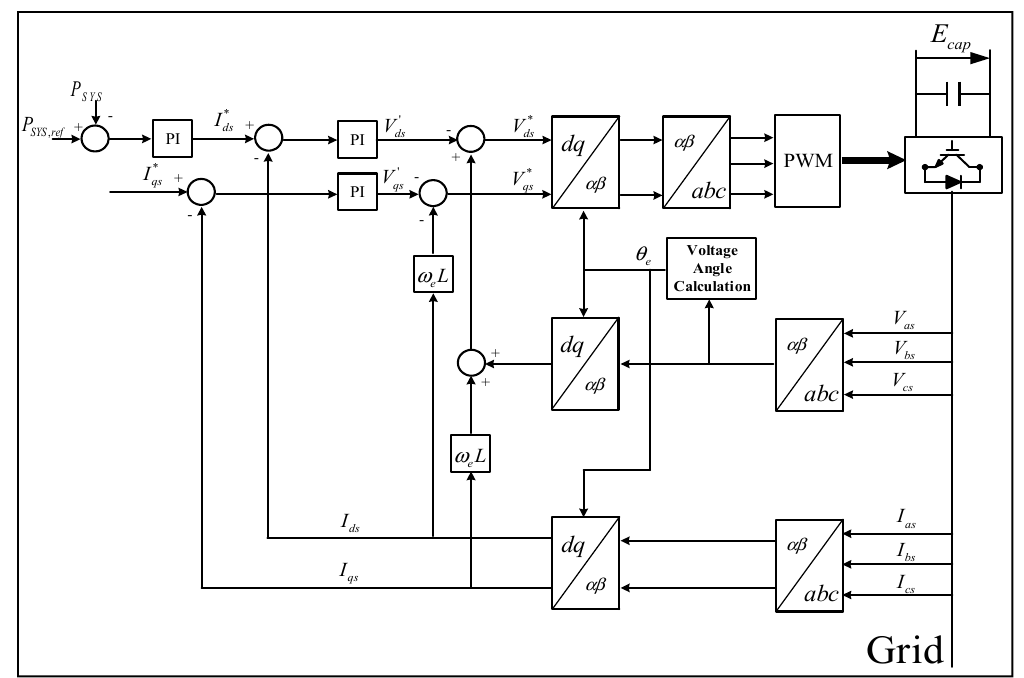
Figure 32. Vector-control structure for an inverter.